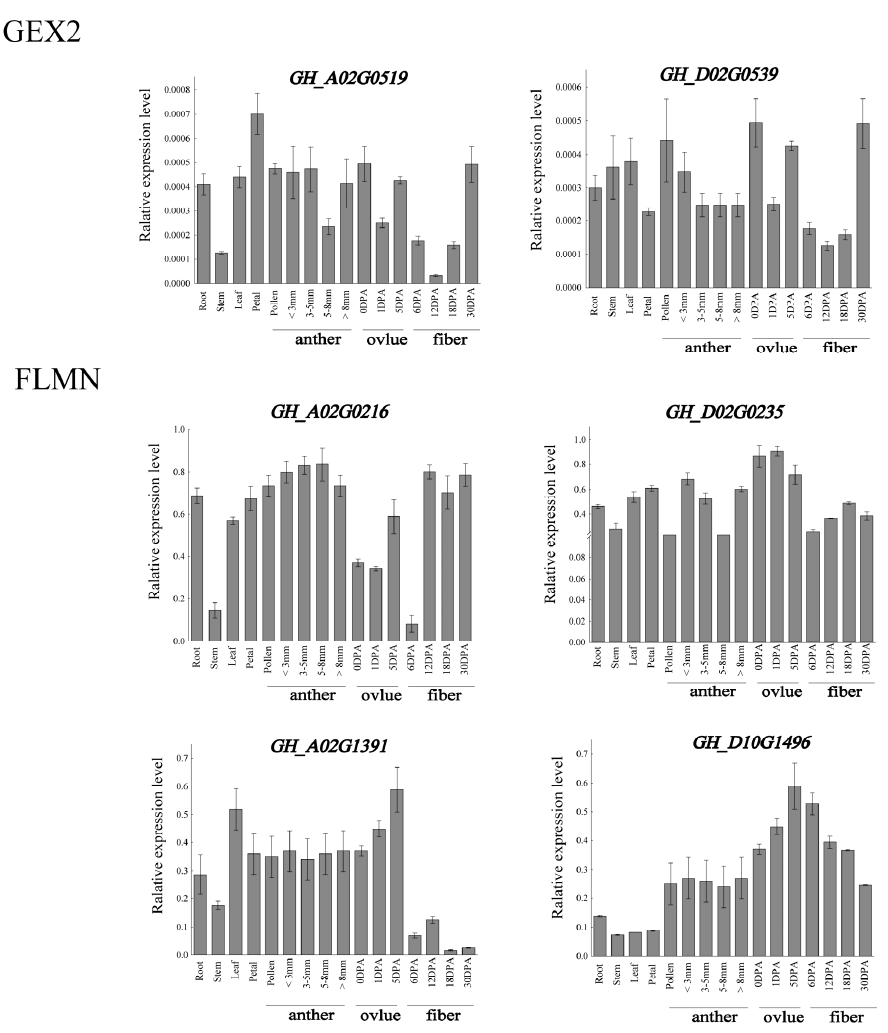
Figure 9. The expression of Filamin gene family members in different tissues of G. hirsutum.